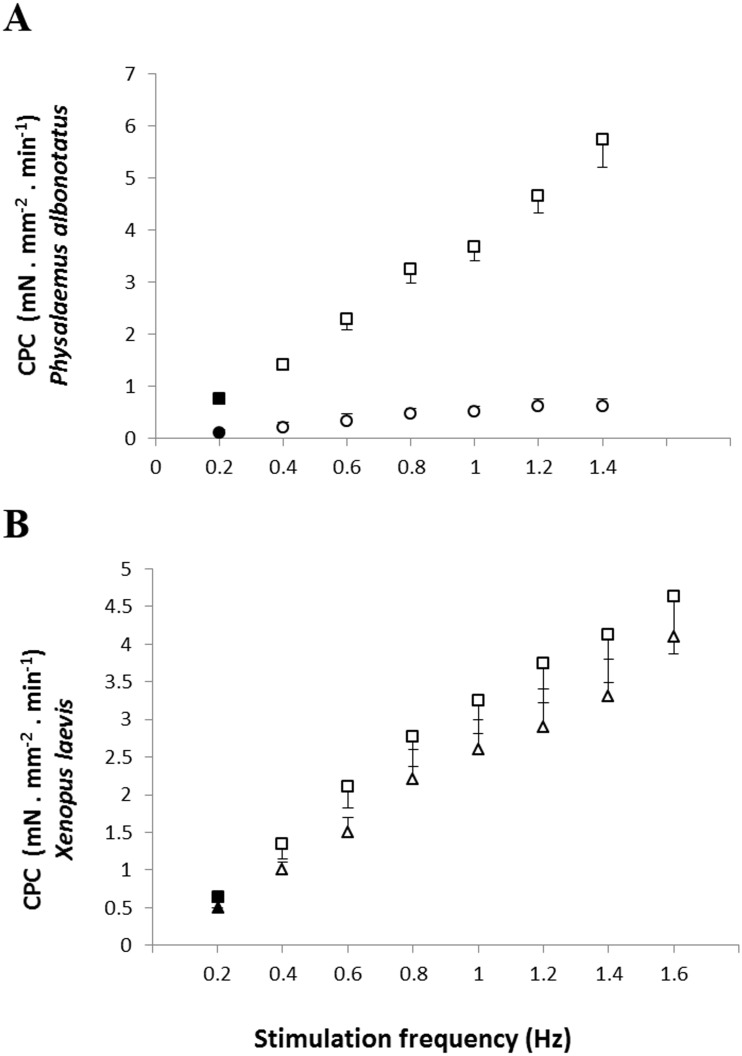
Cardiac pumping capacity of control and infected animals.Effect of the successive increase in stimulation frequencies on the cardiac pumping capacity (CPC: mN mm−2 min−1) developed by the ventricular strips of P. albonotatus (A: squares represent Bd− group - n = 10, and circles represent Bd+ group - n = 10) and X. laevis (B: squares represent Bd− group - n = 8, and triangles represent Bd+ group : n = 9). Points represent the means ± S.E. White markers denote significant difference (Tukey-Kramer test - P < 0.05) between the CPC developed by the same species at each stimulation frequency in relation to the initial frequency (0.2 Hz). Significant differences (Dunnett’s test - P < 0.05) between different treatments (Bd− and Bd+) were observed only in P. albonotatus, in all stimulation frequencies.